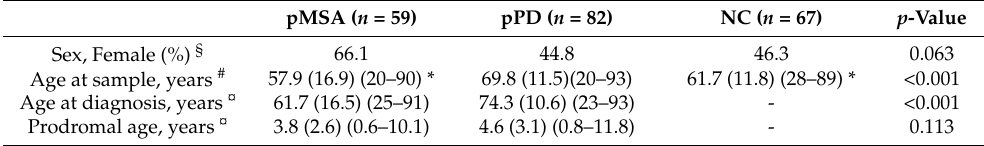
(Table 1). The project was approved by the Regional ethical committee (j.no.: H-15016232) and the Danish data protection agency (j.no.: P-2020-937). All demographic data were blinded to the experimental worker and first disclosed at analysis point. Table 1. Demographic data of prodromal MSA, prodromal PD, and normal